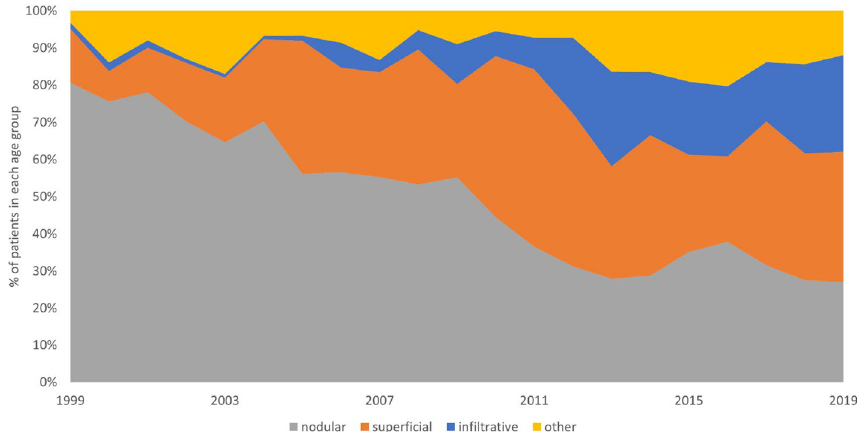
Figure 7. Distribution of BCC subtypes between 1999 and 2019.